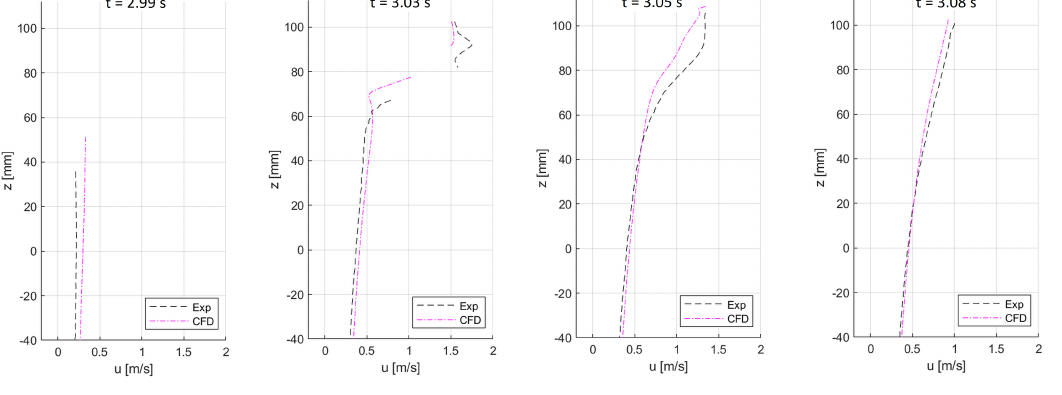
( a ) Contour plots of the horizontal velocity around the instant of breaking. The top row shows the results from the PIV measurement, and the bottom row from the CFD simulation.